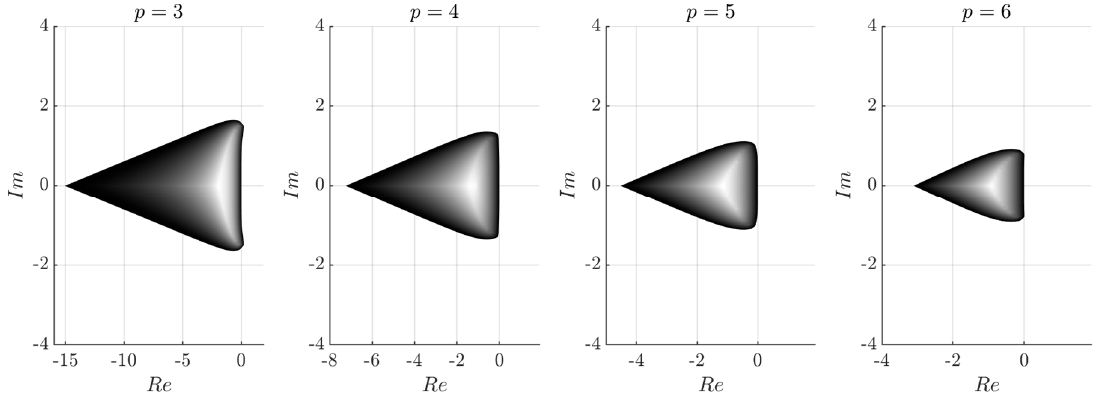
Fig. 10. Stability regions of ESIMM methods of accuracy order p for symmetric test problem matrix ( 𝑘 = 1 )